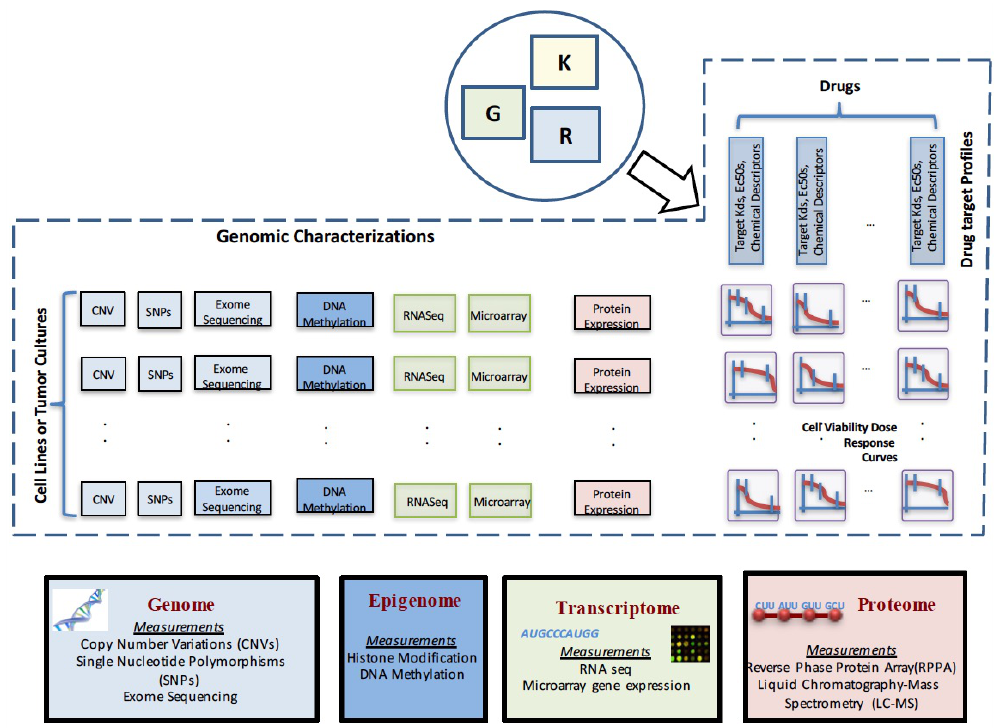
Figure 1. Pictorial representation of the commonly-used genomic and functional characterizations and data types used for drug sensitivity